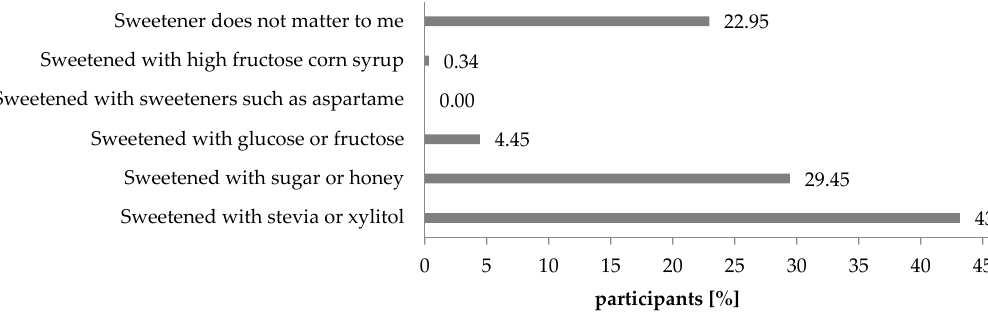
Figure 10. Parent’s preferences regarding the choice of supplements due to the content of sweeteners. Values do not add up to 100%, due to the fact that more than one answer was